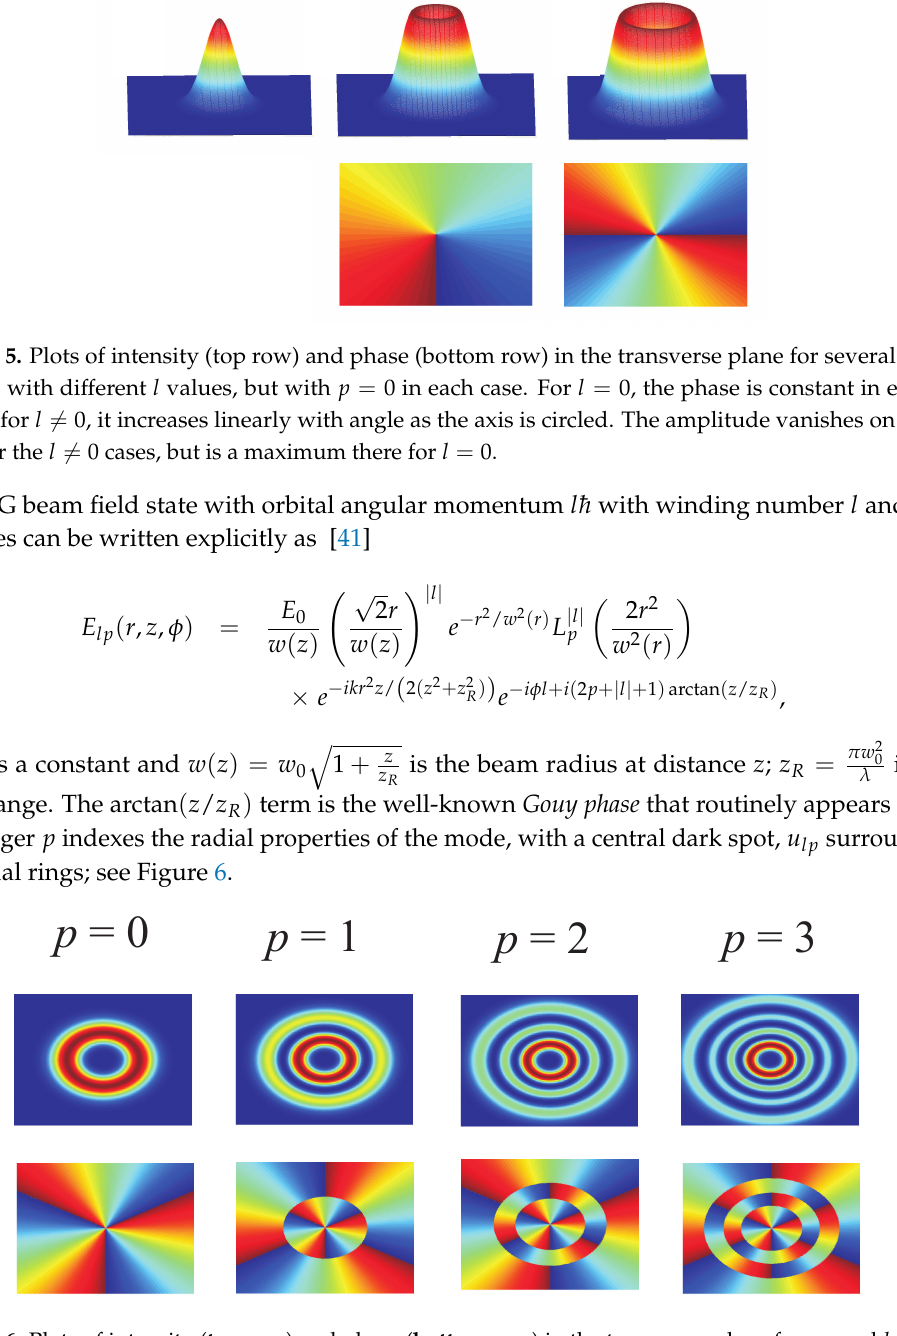
Figure 6. Plots of intensity ( top row ) and phase ( bottom row ) in the transverse plane for several l = 3 LG modes with different p values. In addition to the intensity zero on the axis, there are p nodal rings on which the amplitude vanishes (the dark blue rings). The phase is discontinuous in the radial direction at each nodal ring, while increasing linearly in the azimuthal direction in each